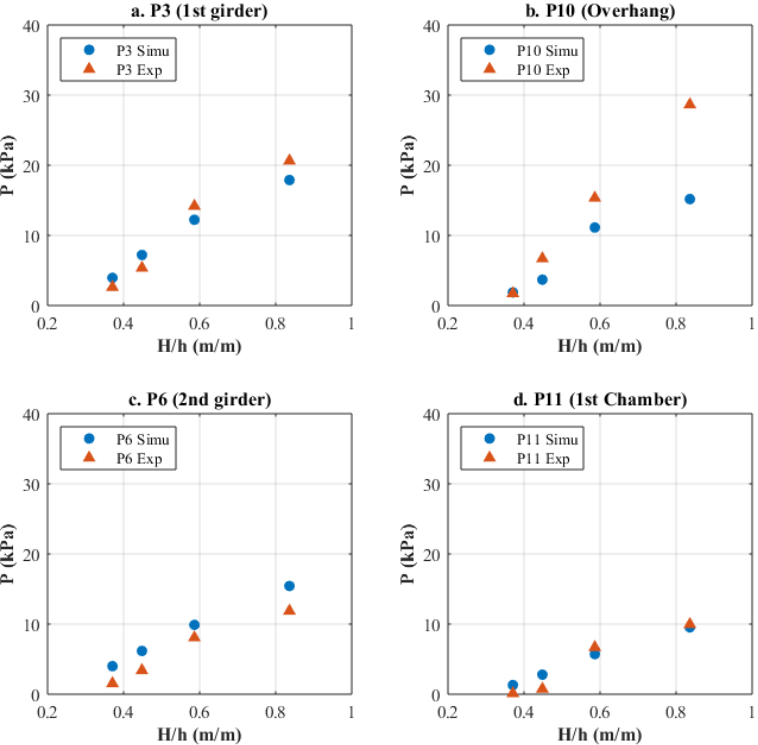
Figure 5. Comparison of maximum pressure at selected locations obtained from the experiments of Istrati [19] and the numerical simulations.